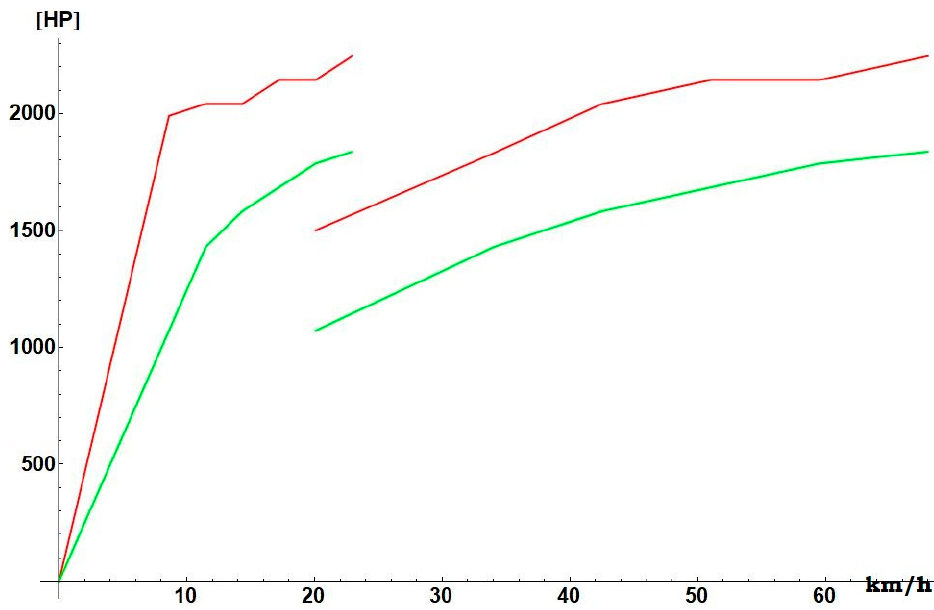
Figure 12. SHEV continuous power required at sprocket continuously (green curve). The red line is the instantaneous power from the SHEV motors.